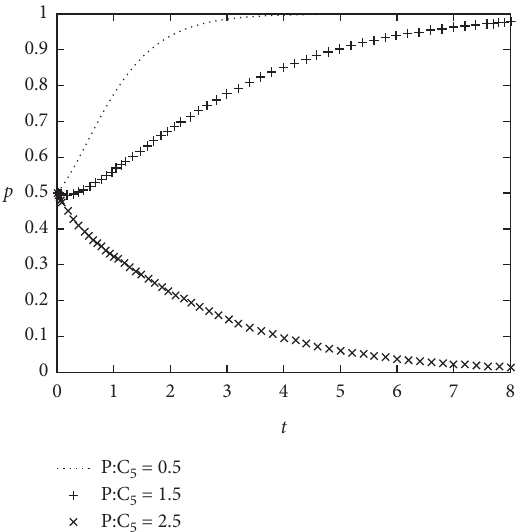
Figure 8: The impact of supervision cost on evolutionary behavior of the